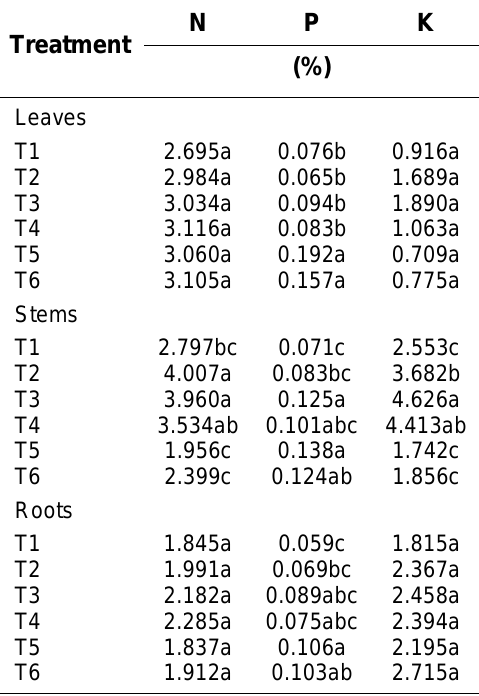
significant difference between means using Tukey’s test at p =